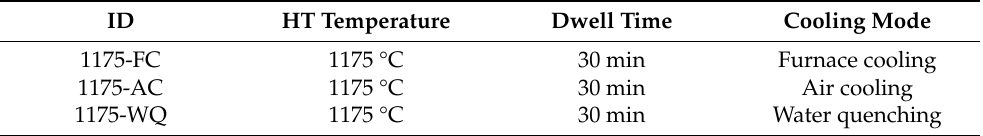
Table 2. The heat treatments used in this study.